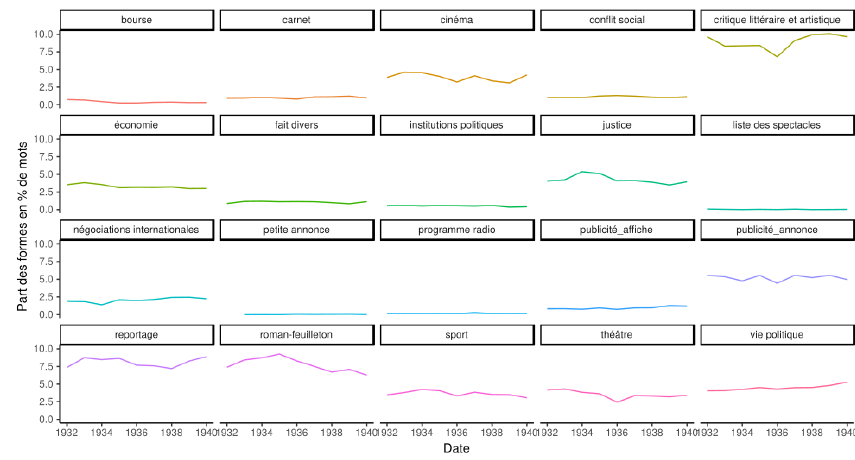
Classification automatisée des articles de Marianne (1932–40) et